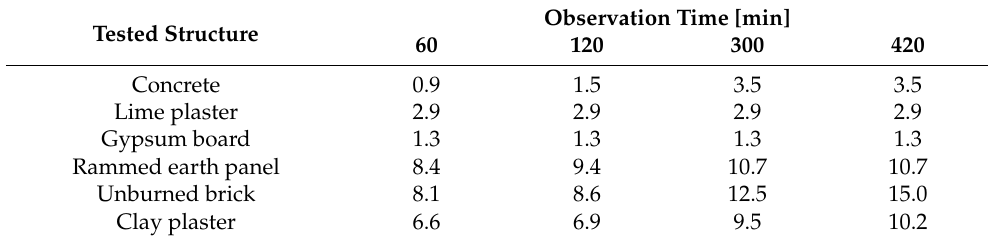
Table 2. The size of the adjusted confidence interval (ACI), in%. Tested